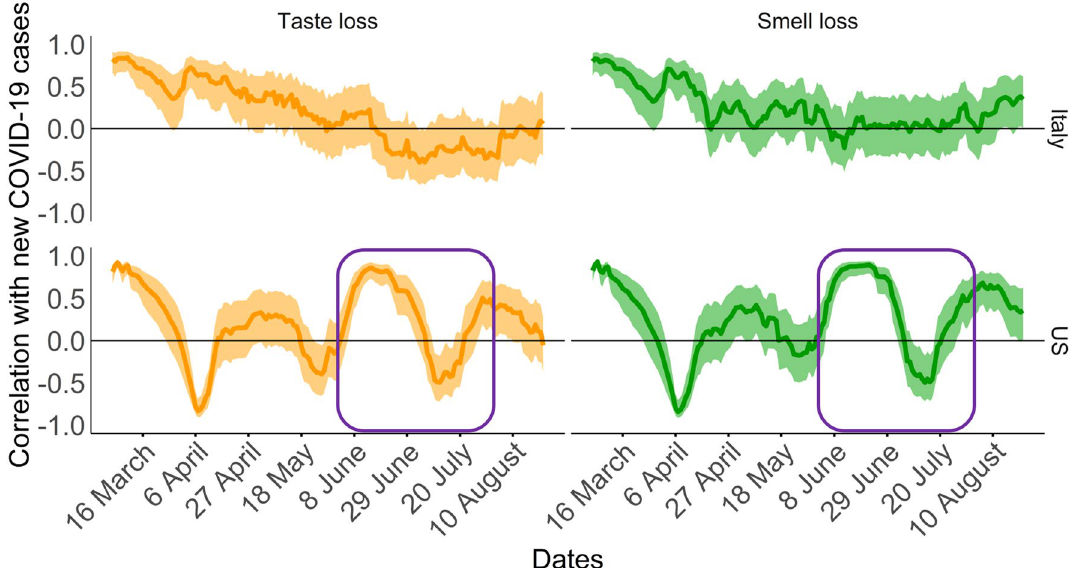
Figure 3. Sliding windows correlation data (time frame of 31 days). Correlation values between the total number of new COVID-19 cases in Italy and US, normalized with respect to 1,000,000 inhabitants, and search queries popularity index. Conservative confidence intervals of 90% are shown as ribbons. Correlation values including the dates in which a second increase in the number of new cases in the US is shown in a purple rectangle.